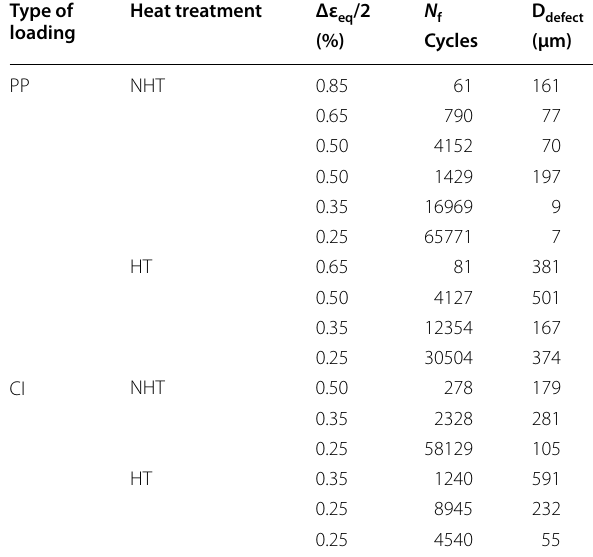
Table 1 Relationship between the strain amplitude failure lives and the defect sizes Type of